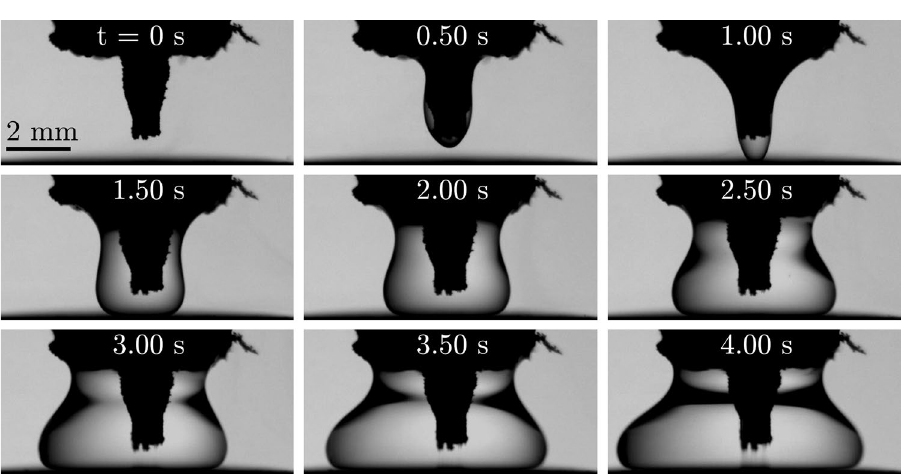
Figure 9. Growth of a needle-bound liquid nitrogen puddle on a warm brass substrate after equilibrium operation of the device at p l ≈ 1.1 bar and p g ≈ 0.5 bar. Starting from equilibrium operation, the pressure in the gaseous line is slightly increased in order to grow the liquid puddle. Time t = 0 refers to the moment, when first liquid is visible to leave the